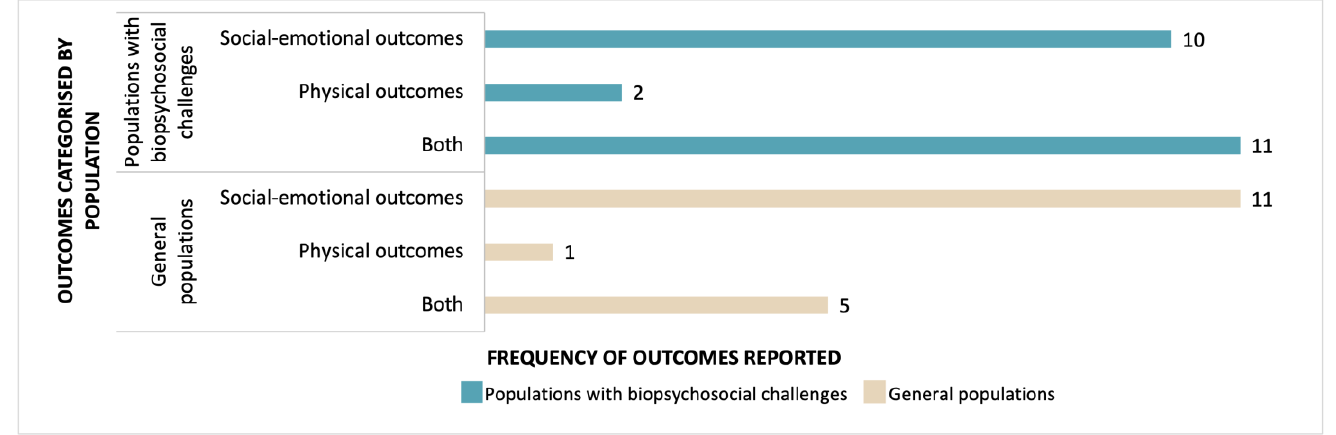
Figure 5. Categorisation of outcomes of circus interventions.